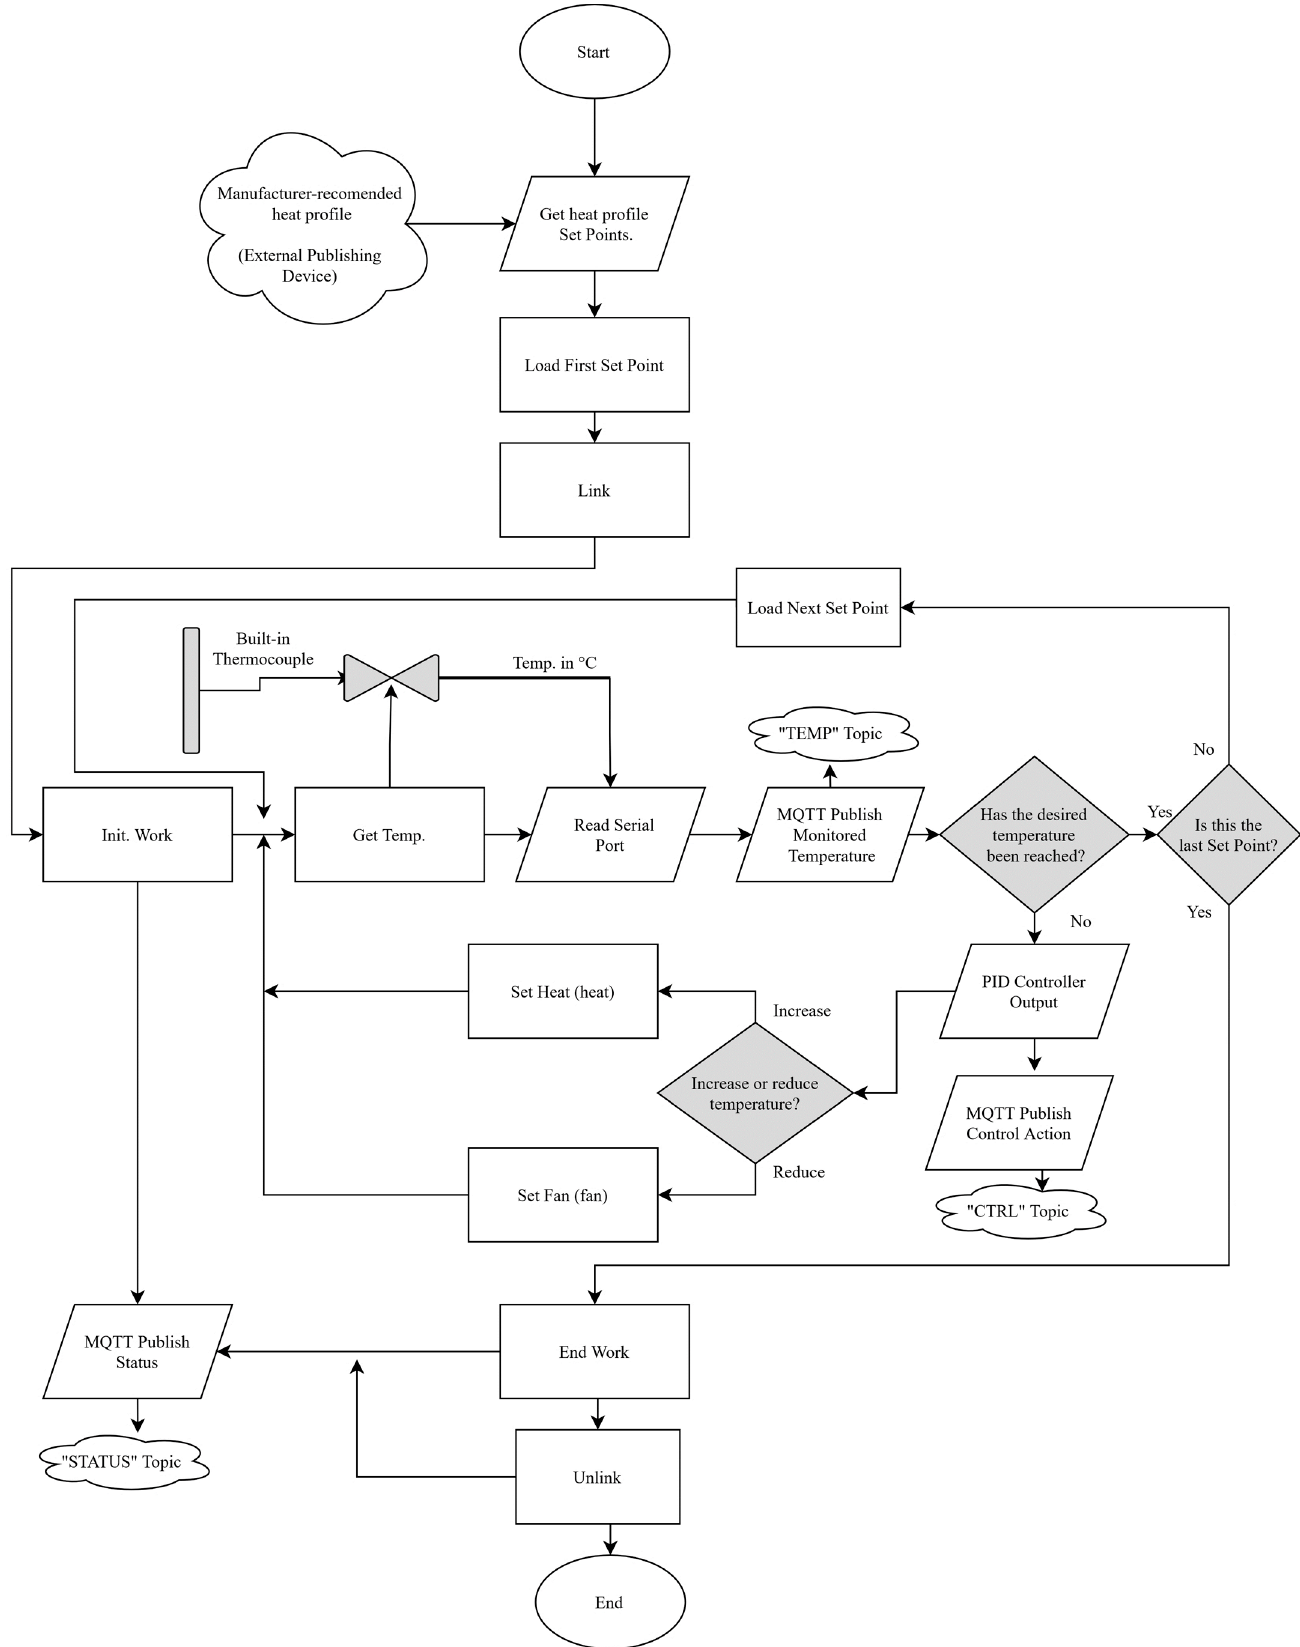
Figure 11. Automated Control Flowchart. Used as a guideline for programming the standalone con- troller.